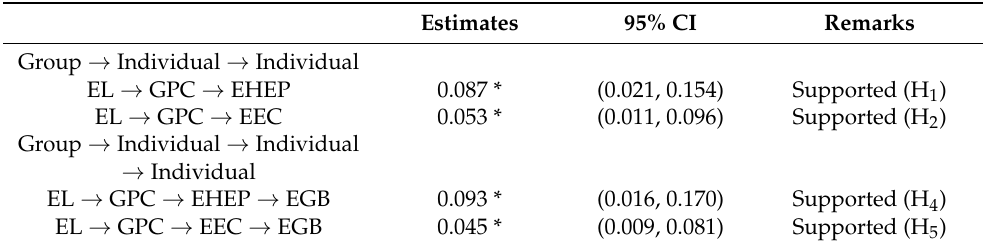
Table 4. Summary of mediation